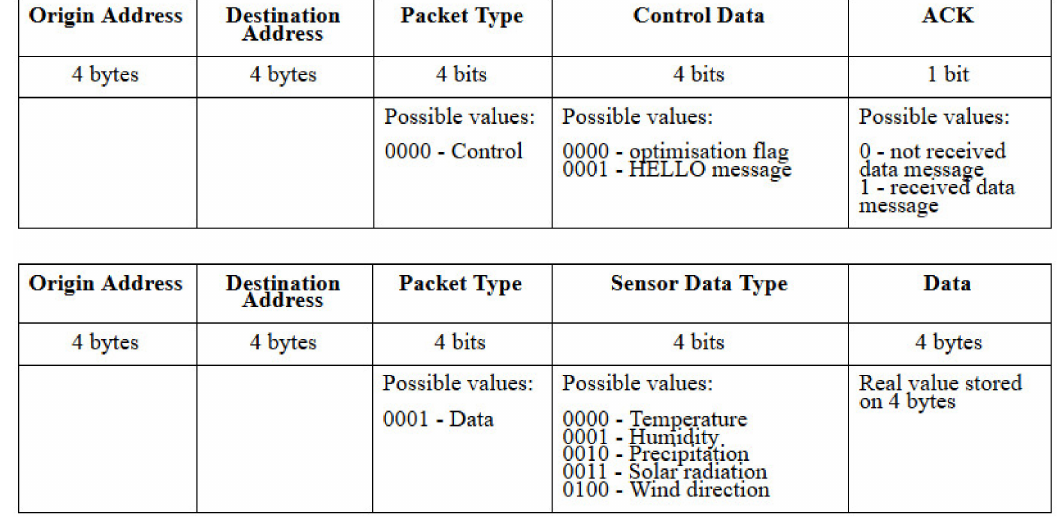
Figure 4. Custom data payload structures for control and sensor data